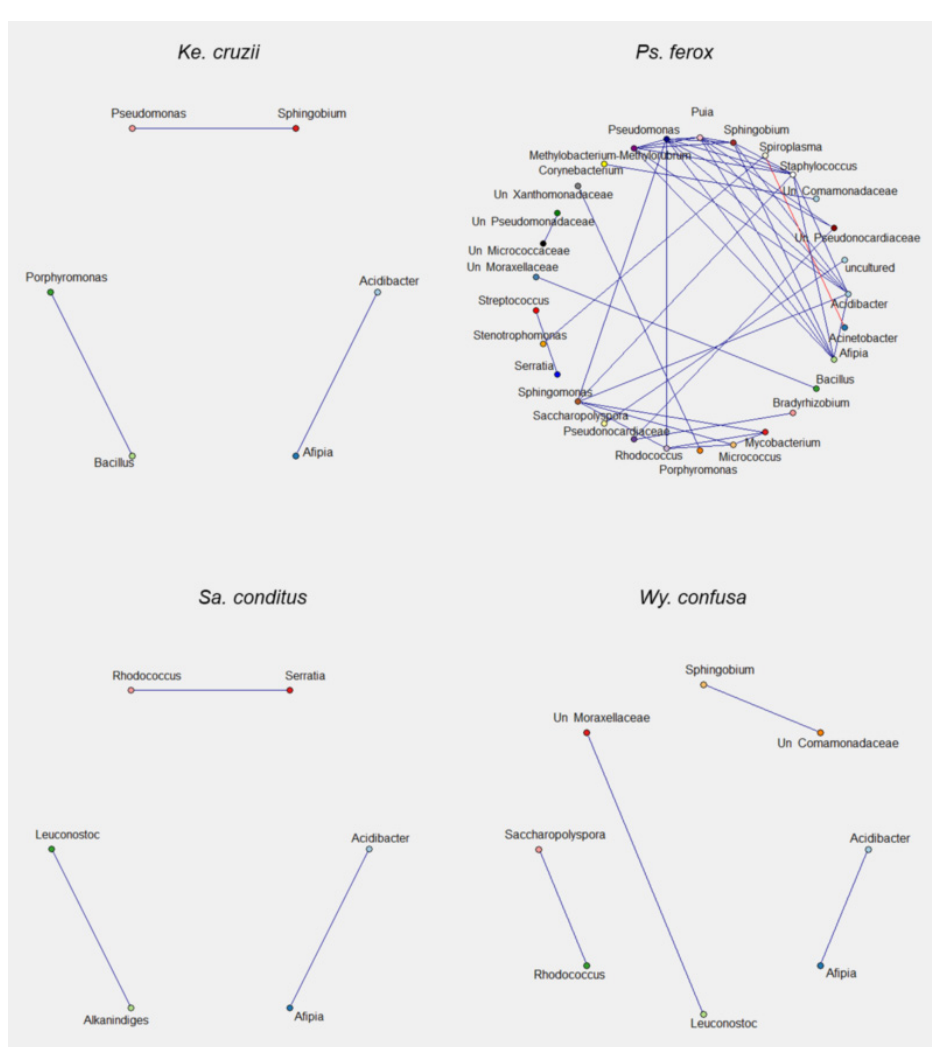
Figure 6. Bacterial interaction network in Ke. cruzii , Ps. ferox, Sa. conditus and Wy. confusa . Each colored circle represents a bacterial taxon. Blue line corresponds to positive correlation between taxa. Red line represents negative correlation between taxa. Correlations were obtained by Spearman and only considered correlations with r > 0.75 and p > 0.05.